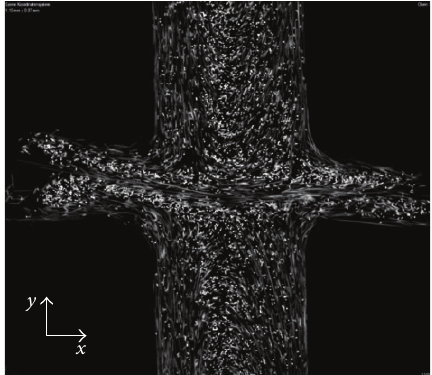
Figure 22: CT picture of the weld of PP-LGF30 with fiber orienta- tion resulting from injection molding at the end of the flow path (DP